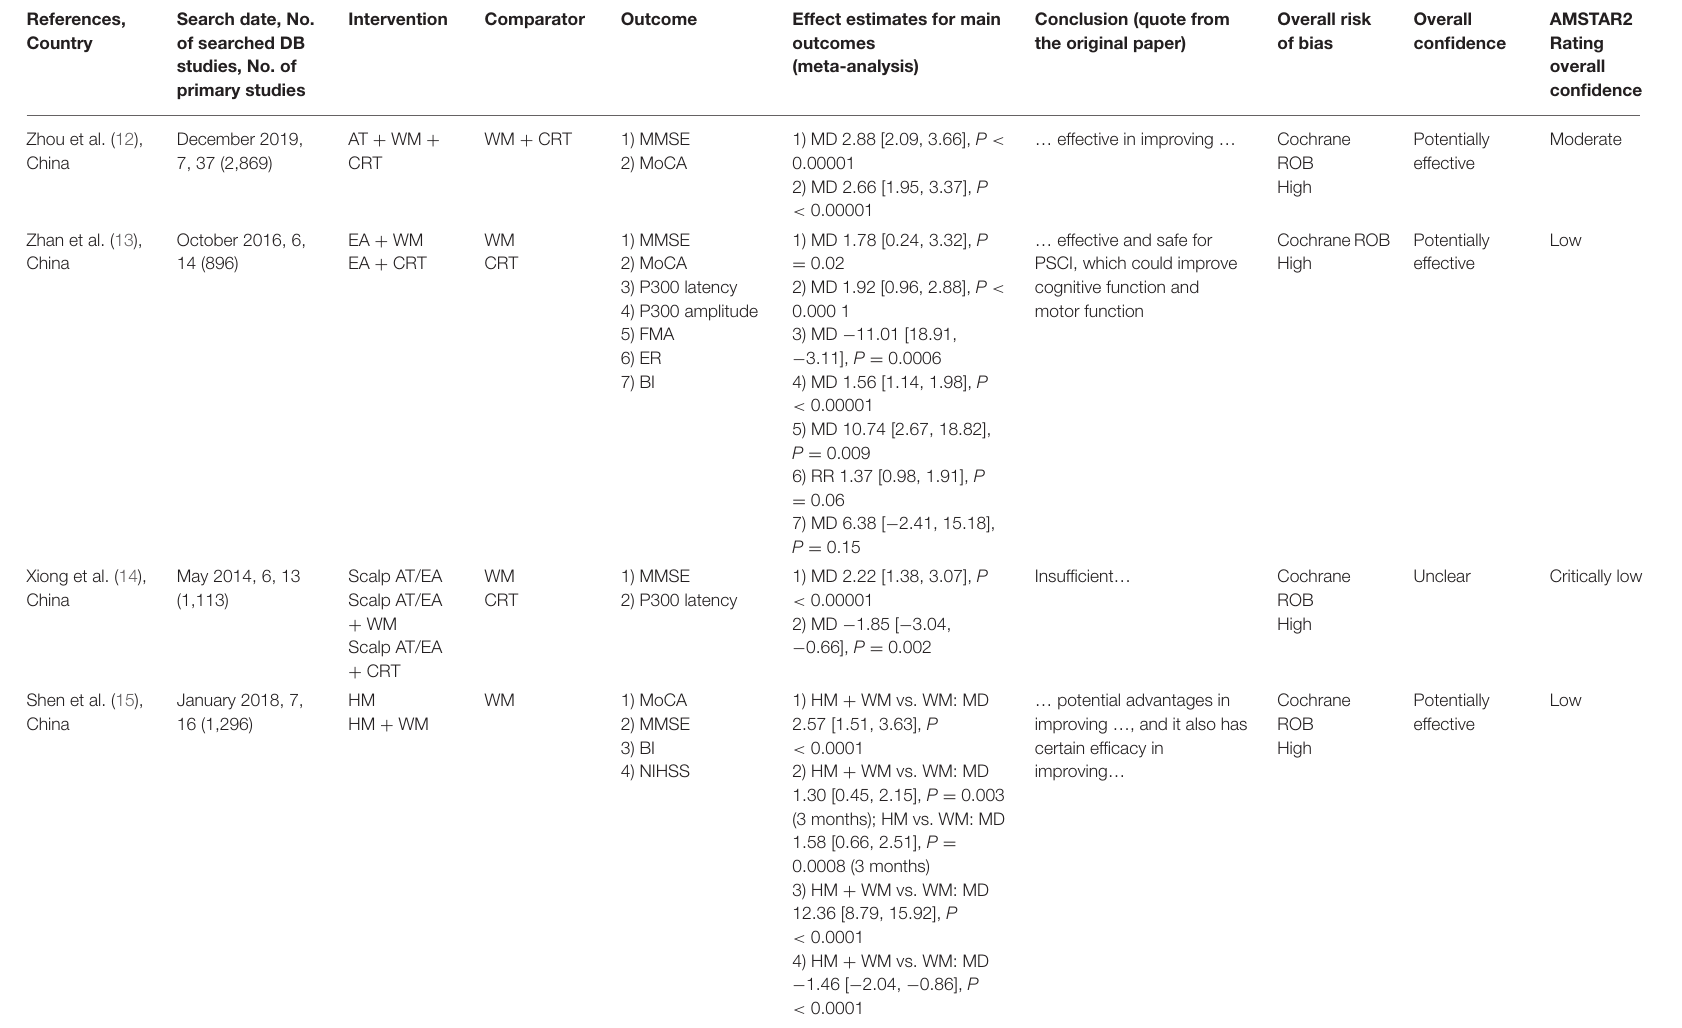
TABLE 1 | Summary of the included systematic reviews of post-stroke cognitive impairment